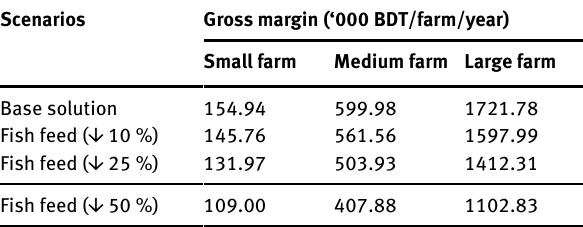
Table 7: Less fish feed availability effect on farm profitability